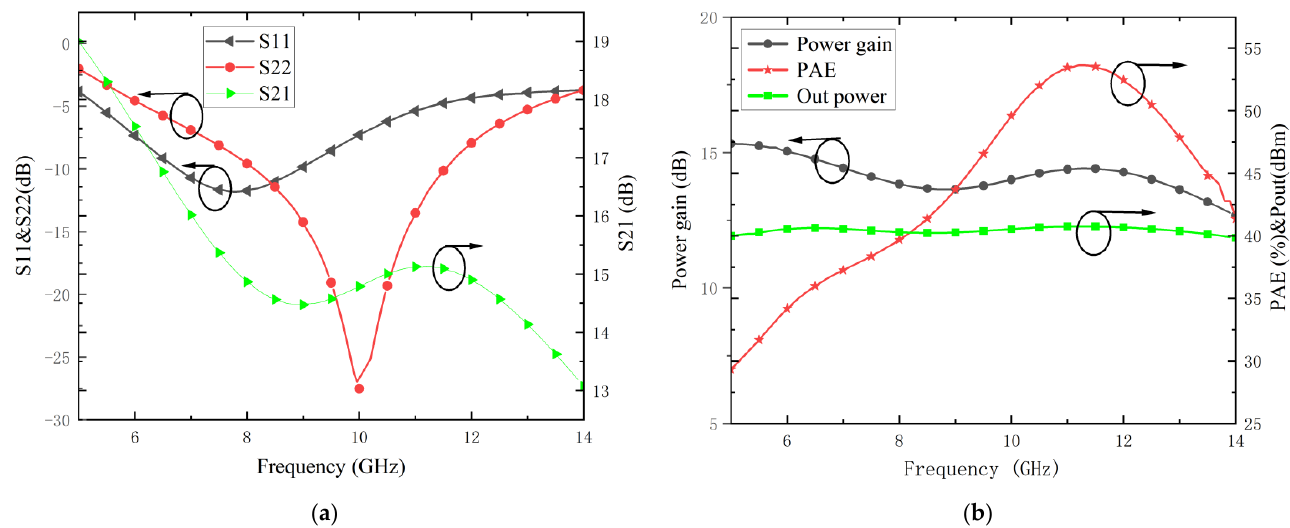
Figure 13. Layout simulation results: ( a ) results for small signal; ( b ) results for large signal .